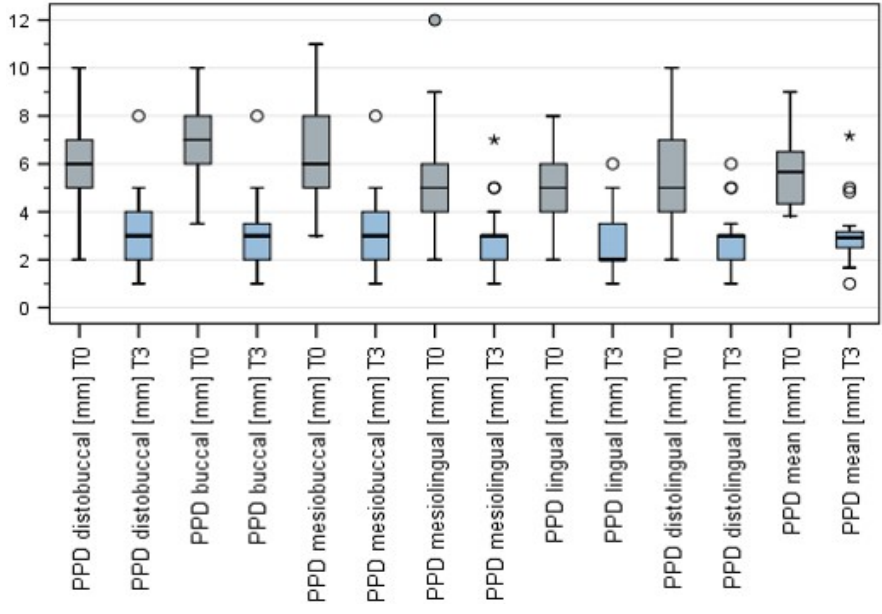
Figure 4. Changes in PPD at T0, T1, T2, and T3. “ ◦ ” = outlier, “*” = extremum. While BoP and suppuration at T0 were 100%, BoP was assessed at T2 to be 36.8% (seven sites) and at T3 BoP to be 35.3% (six sites). The values for pus were 10.6% (2 sites) at T2 and 11.8% (2 sites) at T3. Two sites were diagnosed as having a mild periimplantitis at T2. No statistically significant change was assessable for BoP (McNemar’s test, p = 0.275) and in the diagnosis of periimplantitis (Bowker’s symmetry test, p = 0.392) between T2 and T3. 4. Discussion A pre-requisite for the successful treatment of periimplantitis is the elimination of its provoking factor. This includes the complete debridement of the peri-implant defect, the thorough decontamination of the implant surface, and the removal of potential contributing factors, as well as protecting the wound environment during the healing phase (flap closure). Hence, the initial phase (T00) aimed to reduce inflammation. As PSS cleaning has been demonstrated limited benefit in the literature, we treated implants after removing restorative parts using a powder spray system. Nevertheless, positive BOP and pus were assessed in all of the implants at the surgery date. In our data, PSS failed to eliminate infection and inflammation after this 14-day period. Nevertheless, the investigator’s clinical feeling expressed a certain reduction in inflammation. More data should be collected to investigate if repeated pretreatment with PSS could reduce inflammation, which may be beneficial for later surgery. Initially, this study was designed as an RCT to assess differences in healing and efficacy after EC and PEC [16]. This demonstrated that there was no statistical difference between the groups, meaning that additional cleaning with PSS demonstrated no additional benefit. At T2 (12 months after surgery), 2 EC and 5 PEC implants had to be removed. In contrast to the majority of other studies, we did not exclude severe cases and other compromising factors. The bony reconstruction of periimplantitis-related defects is compromised by inflammatory conditions in the surrounding tissues [4] compared to augmentation procedures in